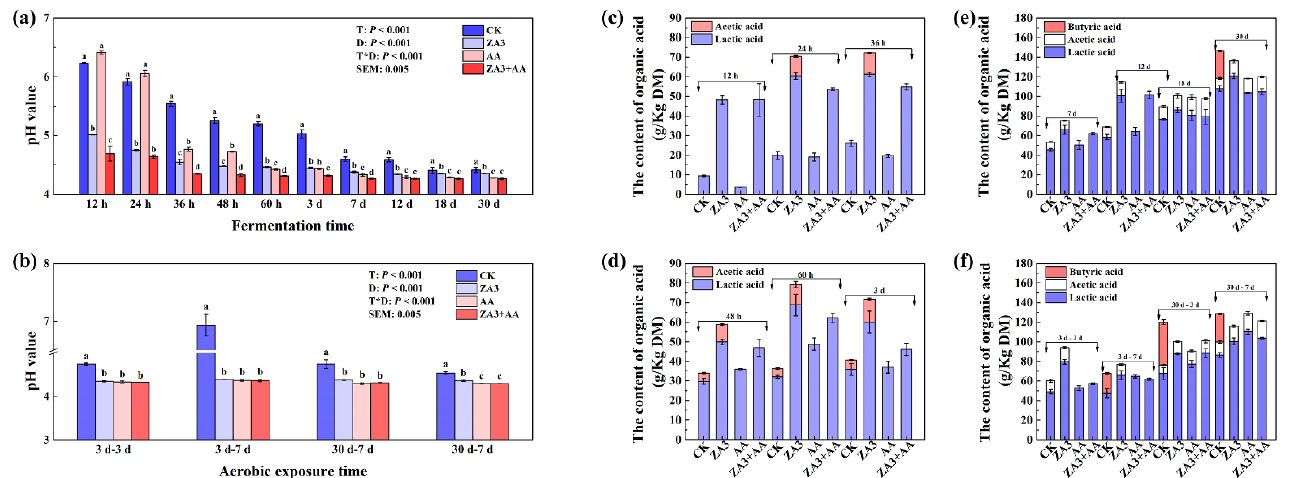
Figure 2. Fermentation quality of FSBM during fermentation and aerobic exposure. ( a , b ), pH value; ( c – f ), organic acid. Different lowercase letters (a – d) for the same treatment time indicate significant differences ( p < 0.05) among different treatment groups according to Student – Newman – Keuls test. The significant difference between days and treatment interactions is expressed as p < 0.001. DM, dry matter; h, hours; d, days.